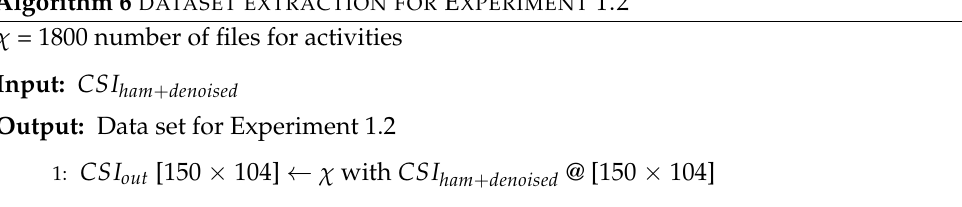
Algorithm 6 used for the LSTM Experiment 1.2 is depicted below: Algorithm 6 DATASET EXTRACTION FOR E XPERIMENT